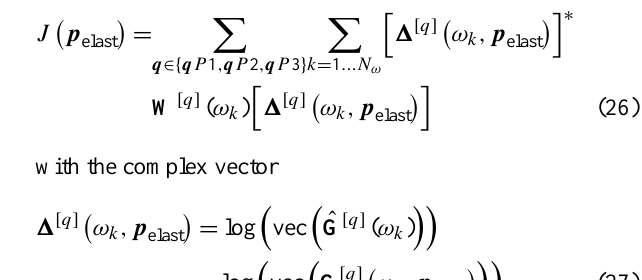
Figure 5. Calculated FRM ˆ G [ qP 1 ] with N r = 4.